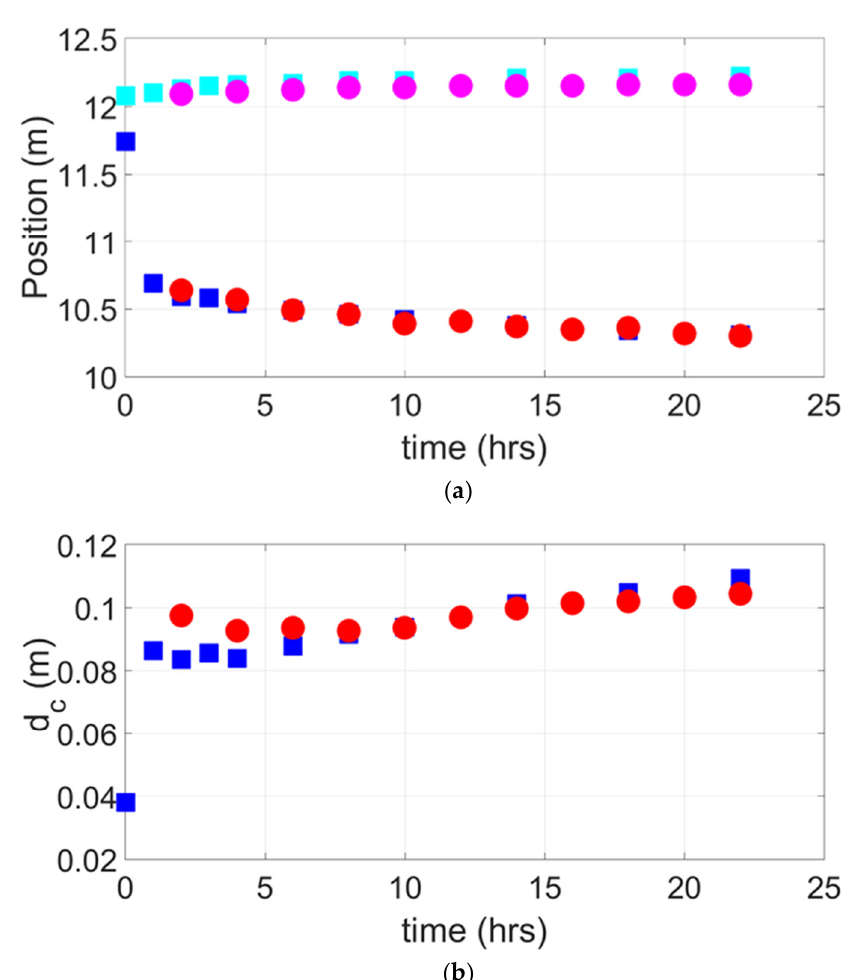
Figure 8. Comparison between the modelled (thick black) and observed mean beach (dashed red line) profile when equilibrium is reached at t = 22 h. The initial (dashed blue) and intermediate modelled (thin grey, in different shades) profiles are also plotted at 2 h intervals.